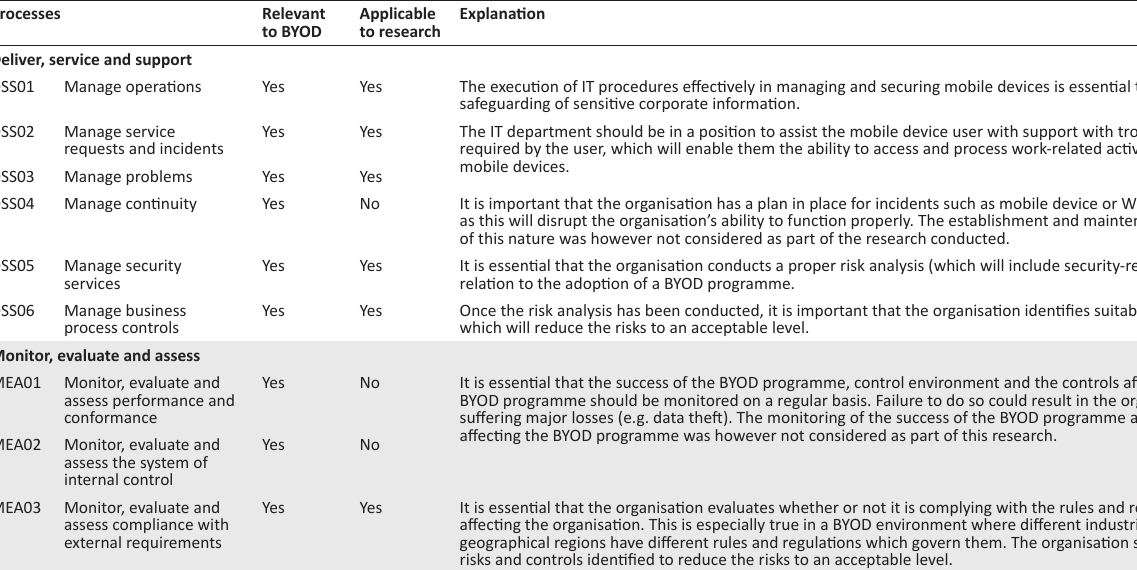
TABLE 2 (Continues...): COBIT process selection. Processes Relevant